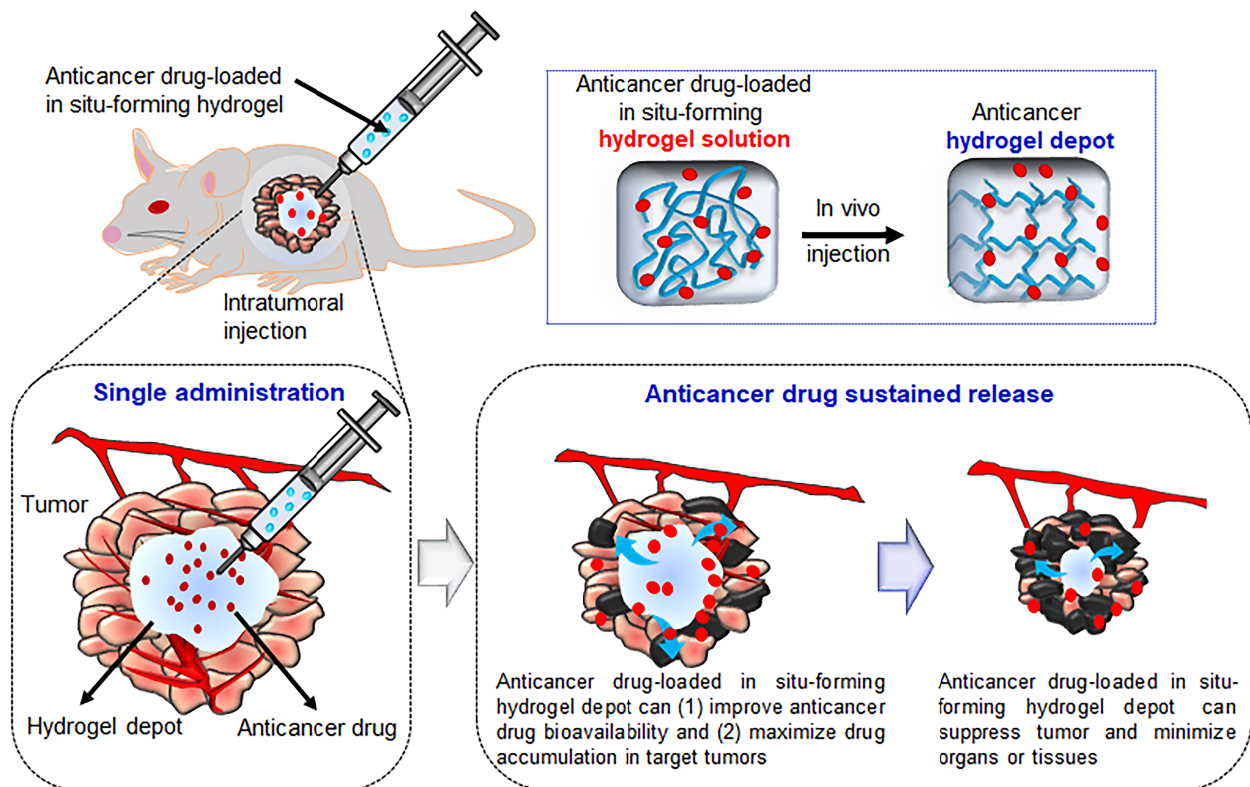
Figure 2. Schematic representation of intratumoral injection of anticancer drug-loaded injectable hydrogels (the image was drawn by G.R.S. and H.E.K. using Adobe Photoshop 7.0).